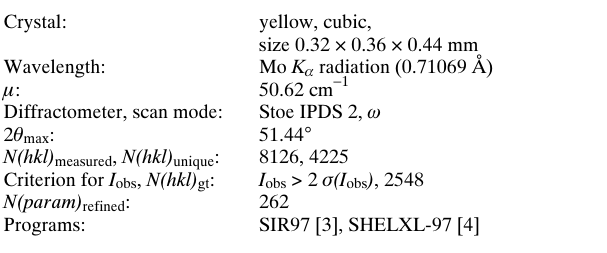
Table 1. Data collection and handling.